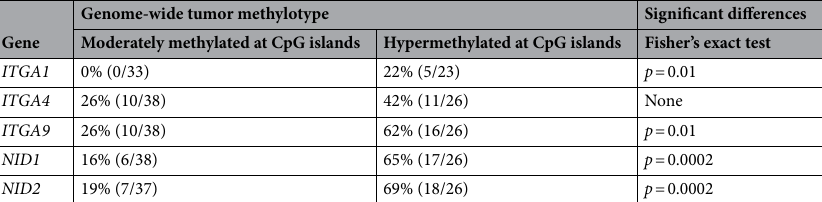
Genome-wide tumor methylotype Significant Gene